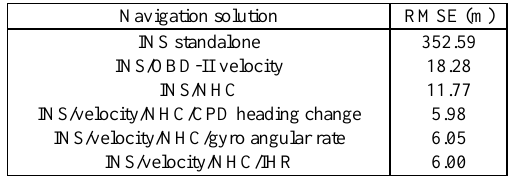
Table 7. Position RMSE for navigation solution of INS/different updates for 180 seconds GNSS signal